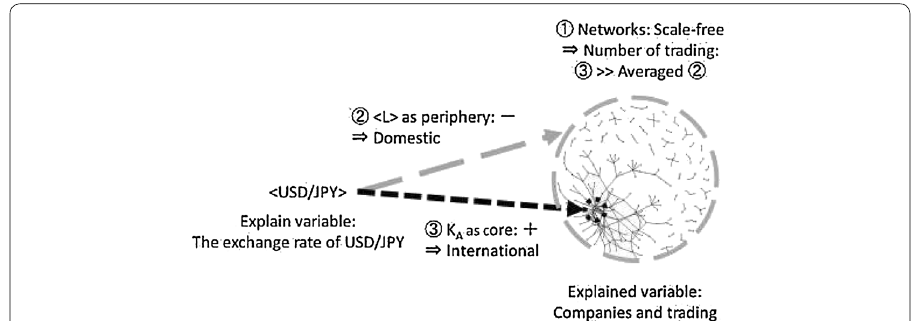
the core networks. The whole networks obeyed the scale-free that comprises the core-networks and the peripheral